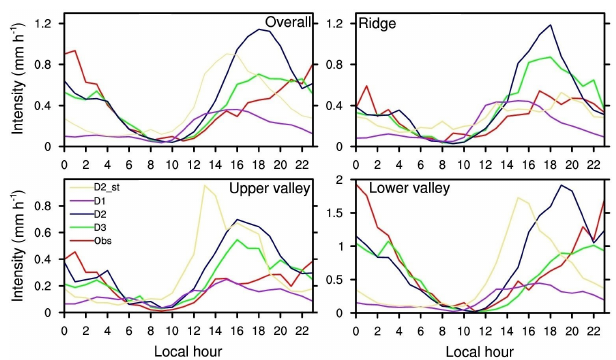
Figure 5. Diurnal precipitation during monsoon seasons at differ- ent WRF resolutions and observations, categorized into overall (all averages), ridge, upper valley, and lower